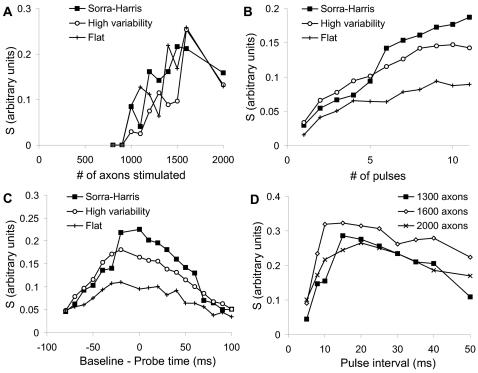
Separation of Responses.Separation S is calculated for three different conditions in (A, B, C): Sorra-Harris synaptic weight distribution with 20% variability between cells, a high (50%) cell-to-cell variability case again using the Sorra-Harris distribution, and a flatter distribution truncated to have the same mean as the Sorra-Harris distribution, also with a 20% variability. (A) Separation S as a function of L, the number of axons stimulated for the baseline. (B) S as a function of N, the number of probe pulses. (C) S as a function of probe-baseline time. (D). S as a function of interval between pulses in the probe and baseline stimuli, for values of L = 1300, 1600 and 2000 axons.